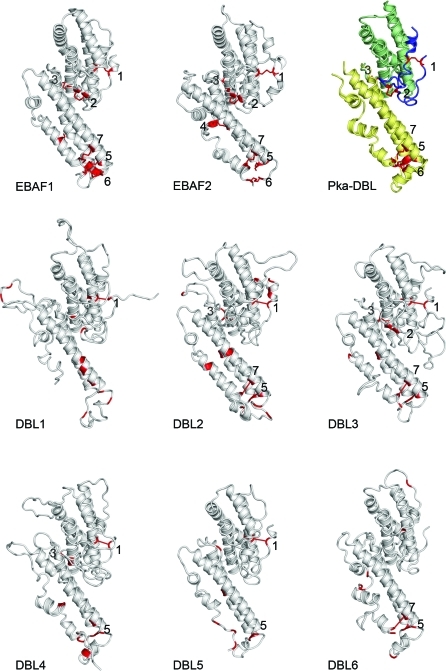
Structure Models of the VAR2CSA DBL DomainsThe experimental structures of the template EBA-175 and Pkα-DBL domains are shown in the first row, and DBL models are shown in the middle and last rows. Sub-domains 1–3 of Pkα-DBL (Pka-DBL) are colored in blue, green, and yellow, respectively. Cysteines in all domains are highlighted in red. Disulfide bonds in templates are numbered according to occurrence in the sequences and corresponding cysteine pairs in the models are numbered with respect to the template numbering.